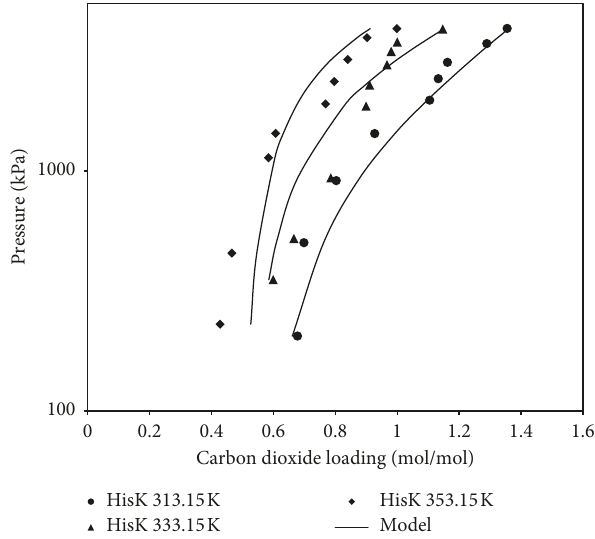
Figure 7: Correlation of modified Kent–Eisenberg model against the experimental solubility of carbon dioxide in 2.5M aqueous potassium salt of L -histidine (HisK).